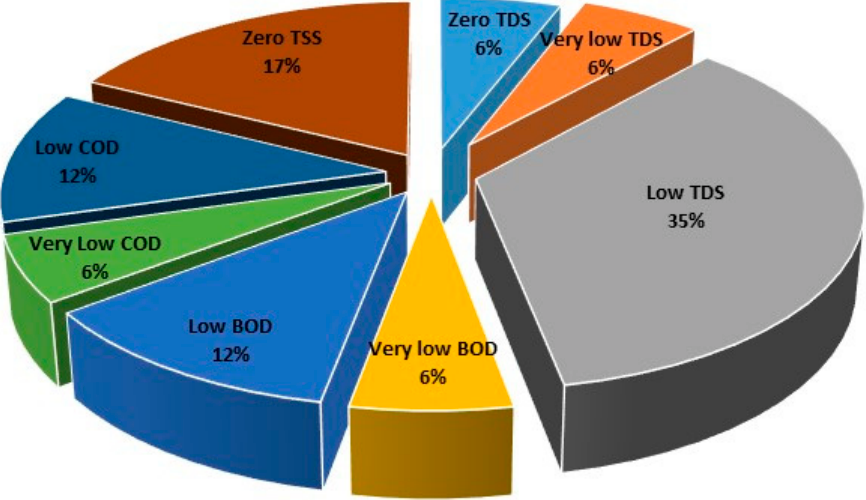
Figure 7. Responses of reclaimed wastewater quality requirements by the major